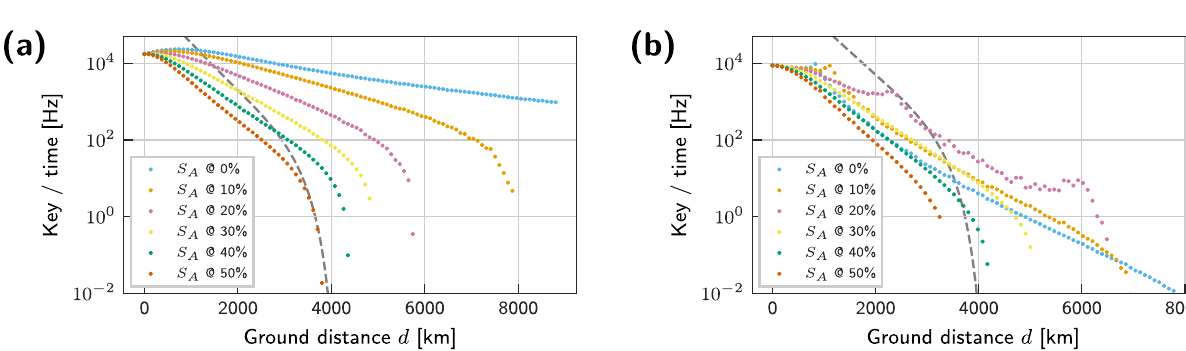
Fig. 3 Achievable key rates for different choices of positions of the satellites. This is a new parameter to optimize when using multiple satellites. Satellite S A is positioned vertically above varying percentages of the total ground distance. The dashed line indicates the BBM92 protocol with only one satellite and a clock rate of 20 MHz. a Scenario 1, a protocol with outer satellites distributing one pair between the ground station and the central satellite each. Here positioning the satellites S A and S B directly above the ground station to avoid as much atmospheric noise as possible proves bene fi cial. b Scenario 2, a protocol that establishes four links of entangled pairs between satellites and stations. Here, the distance-dependent trade-offs are more